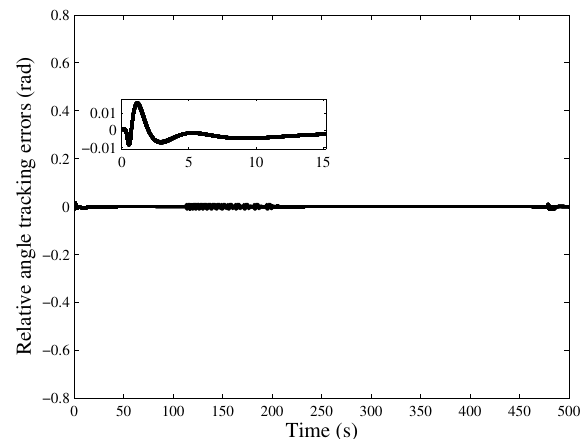
Figure 13. Graphs of the 100-set relative angle tracking errors.